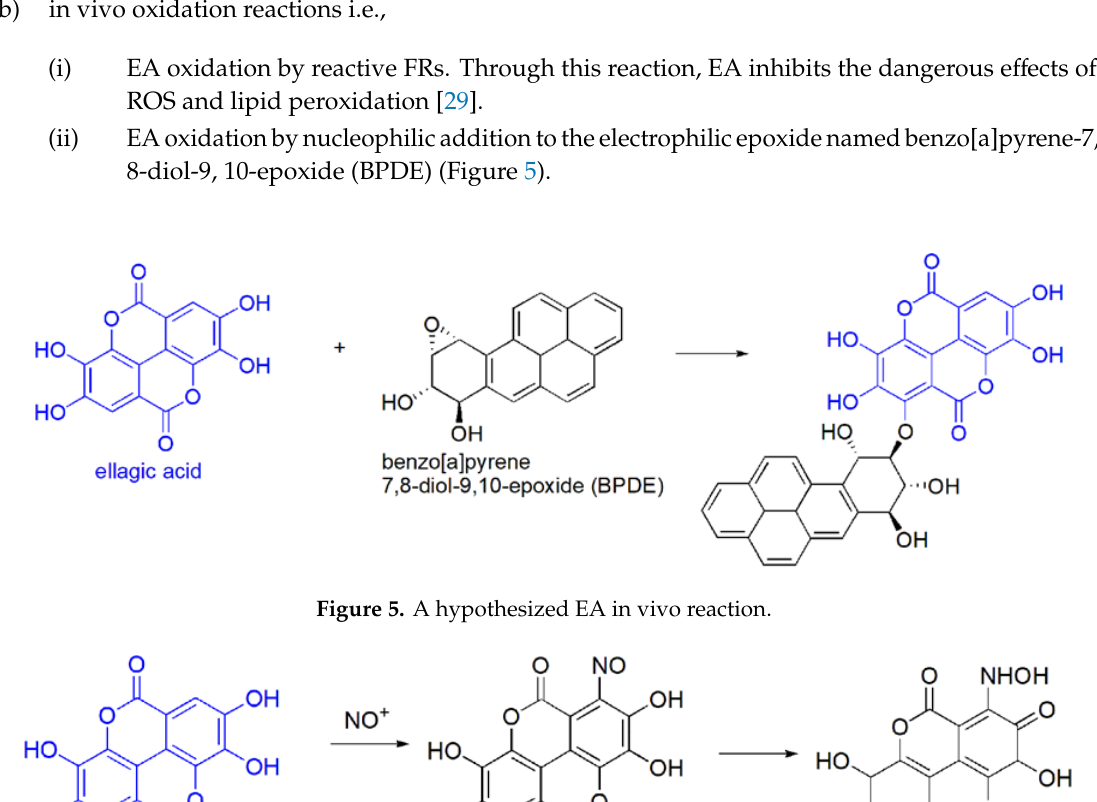
Figure 5. A hypothesized EA non in vivo nitrosation. Figure 6. A hypothesized EA non in vivo